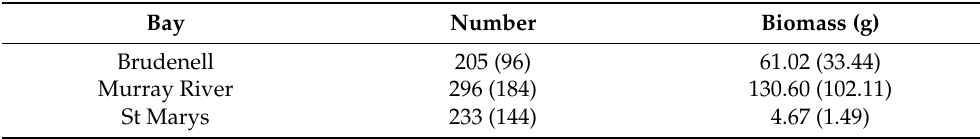
Table 2. Total number and biomass ( ± SE) of Styela clava per 50 cm mussel sock sample (totals calculated from subsamples of juveniles and full samples of